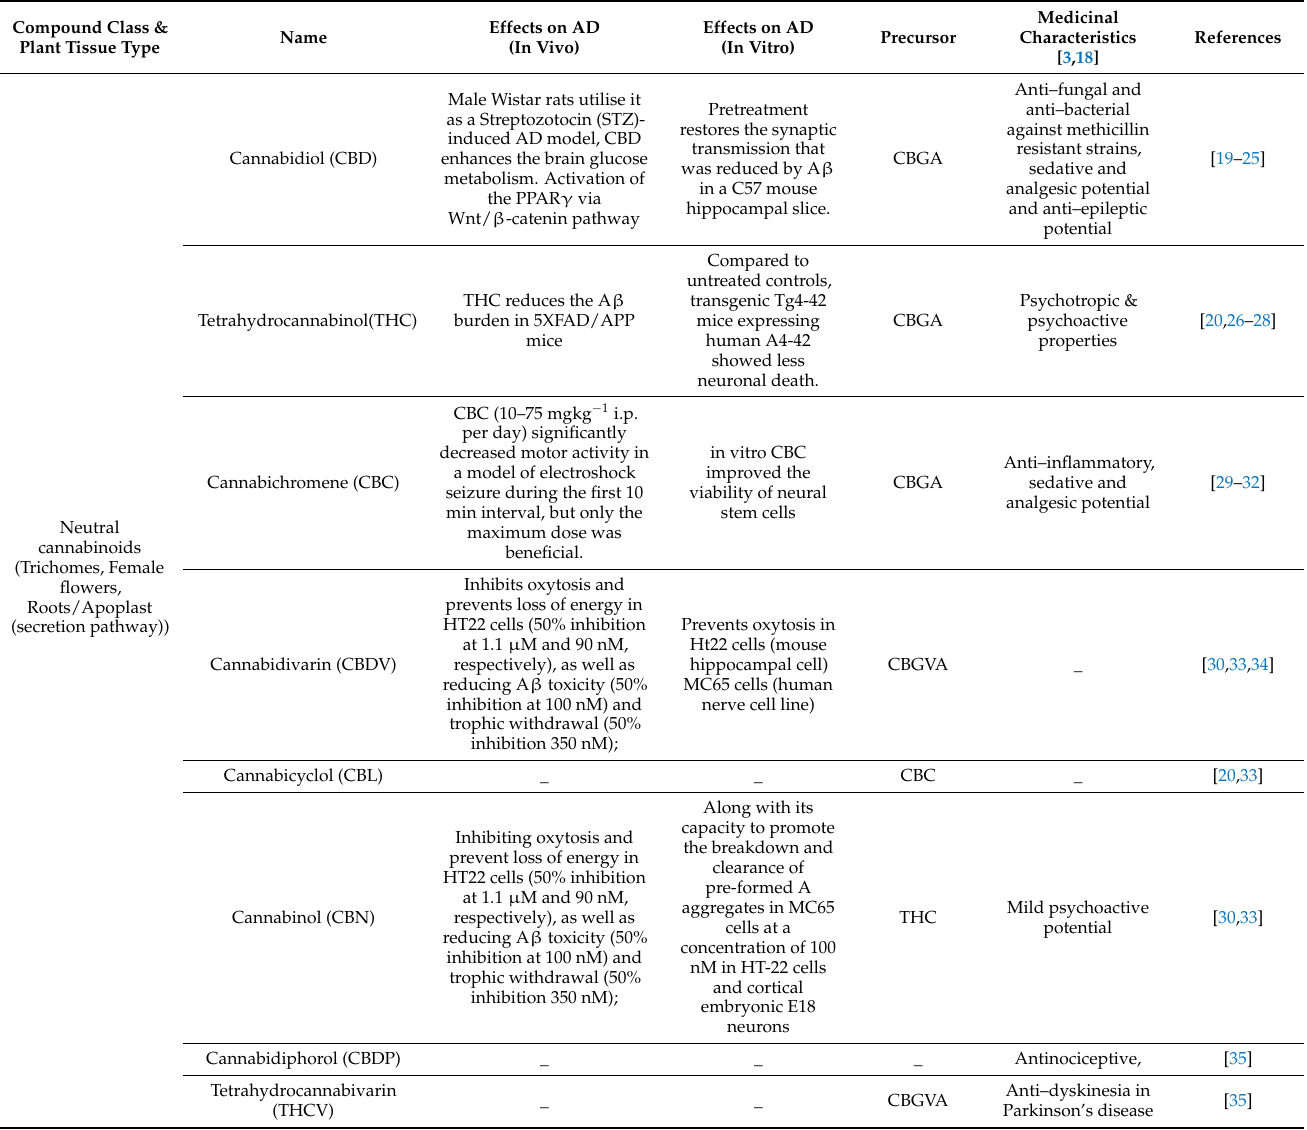
Table 1. Major metabolites reported in extracts of C. sativa which affects the AD pathway and its medicinal